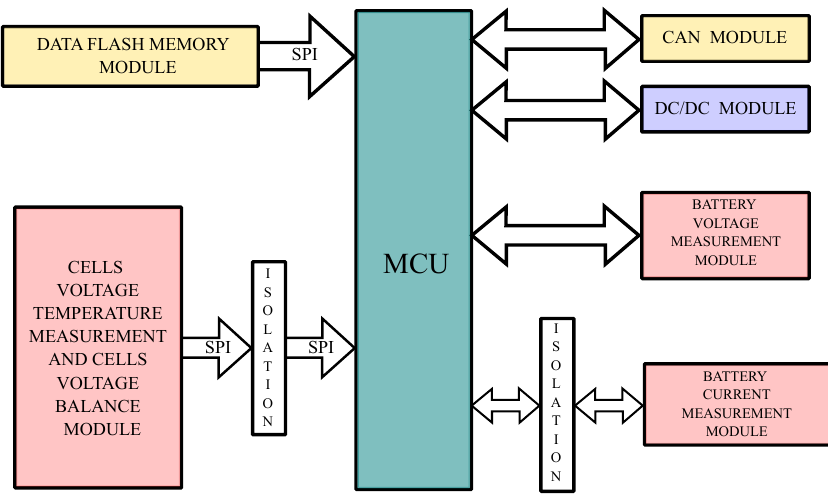
Figure 10. BMS structure